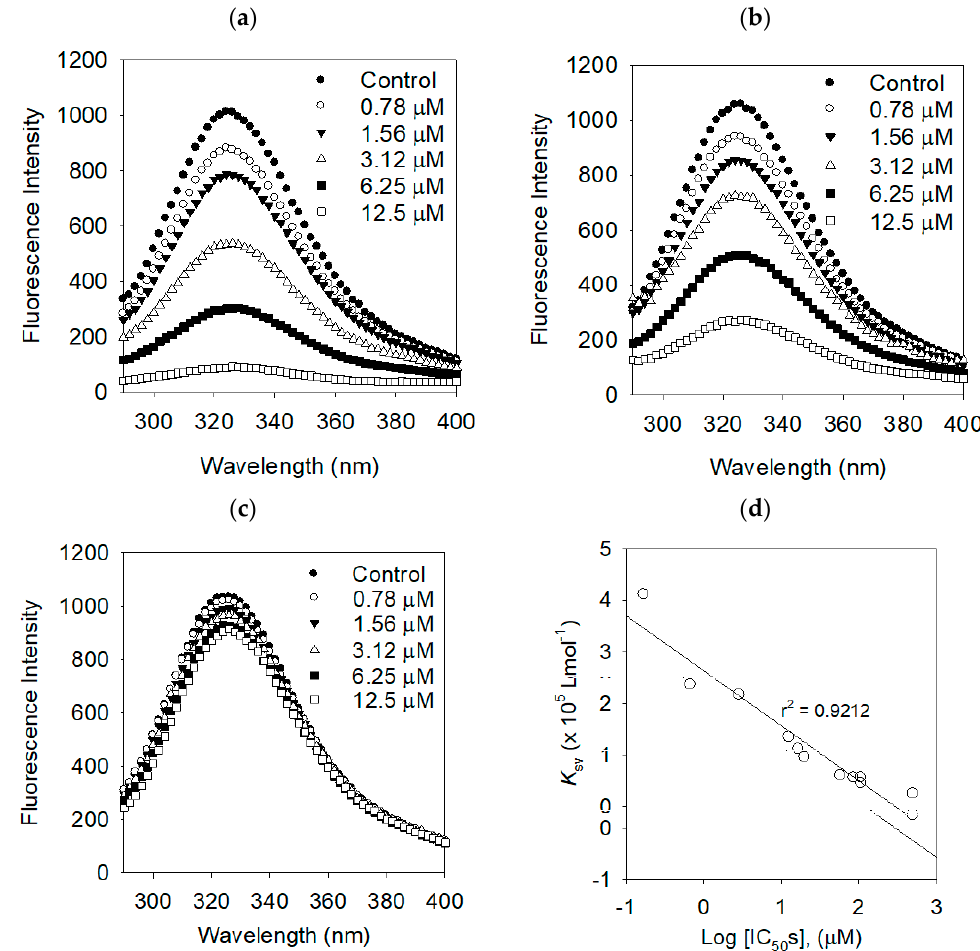
Figure 6. The effects of ( a ) compound 1 , ( b ) compound 2, ( c ) dihydrokaempferol on the fluorescence emission spectra of bacterial neuraminidase, and ( d ) the correlation between the inhibitory potencies (IC 50 s) and the Stern–Volmer constant ( K SV ). Table 4. Fluorescence quenching effects of the isolated compounds ( 1 – 8 ) and their parent compounds (luteolin, dihydrokaempferol, and apigenin) on the bacterial neuraminidase.